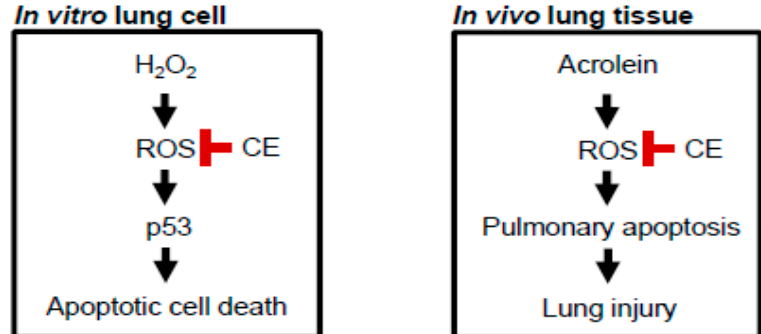
Figure 6. Proposed protective mechanisms of CE against oxidative stress-induced apoptotic death of lung cells in vitro and in vivo. CE antagonizes oxidative stress-induced apoptosis in lung cells exposed to the oxidant environment, thereby establishing the potential development of CE as a therapeutic agent in the treatment or prevention of pulmonary injuries associated with the exposure to highly oxidizing environmental toxicants, such as acrolein.